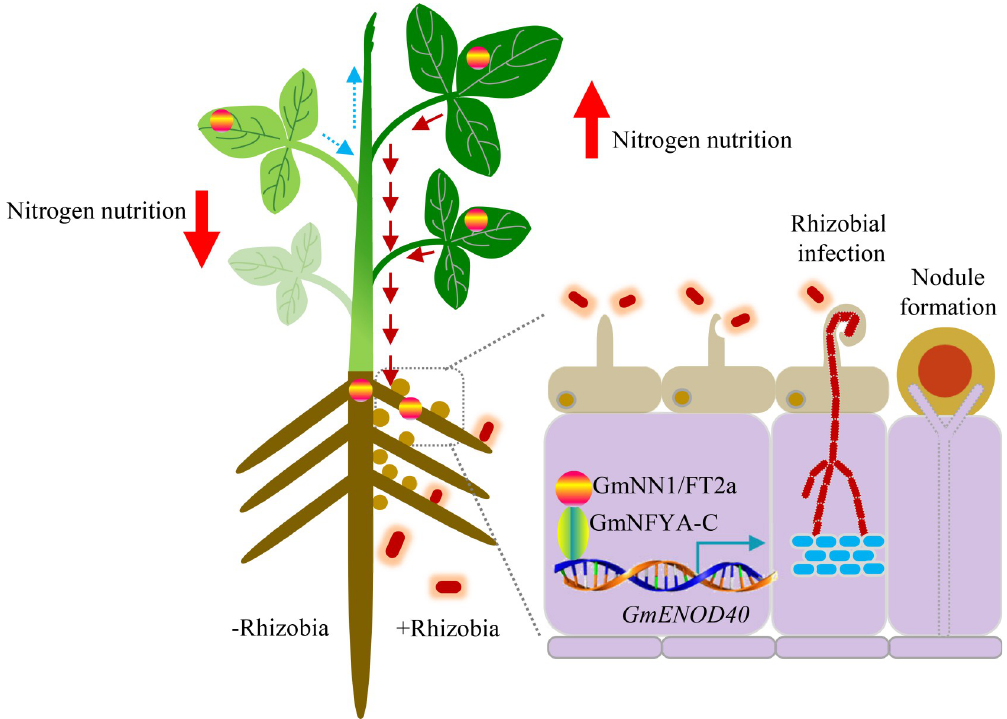
Fig 7. A proposed working model of how the GmNN1/FT2a-GmNYFA-C-GmENOD40 module regulates nodulation in soybean. Shoot-derived GmNN1/FT2a translocates to roots, with its mobility being determined by rhizobial inoculation. In soybean roots, GmNN1/FT2a directly interacts with GmNFYA-C to promote nodulation, and thereby facilitate N nutrition, via activation of GmENOD40 expression.